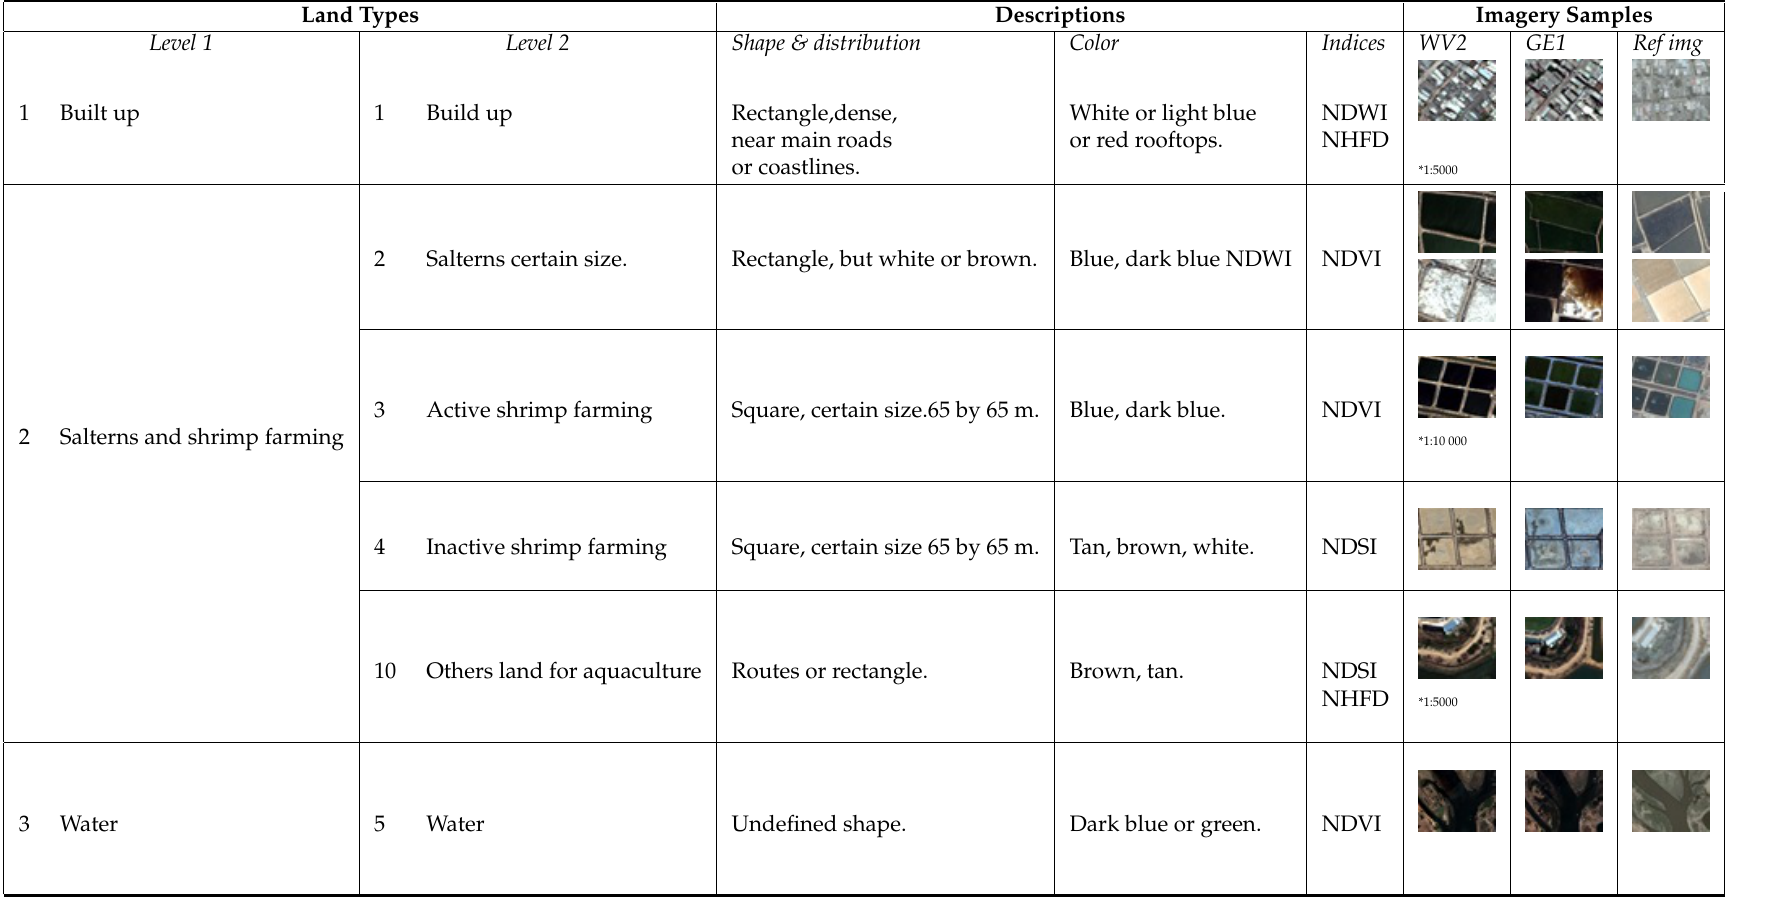
Table A1. Training samples for WorldView 2 and GeoEye 1’s classification